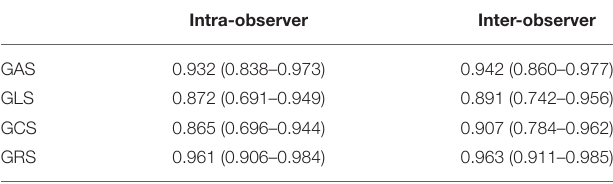
TABLE 4 | Intra-observer and inter-observer reproducibility for 3D-STE